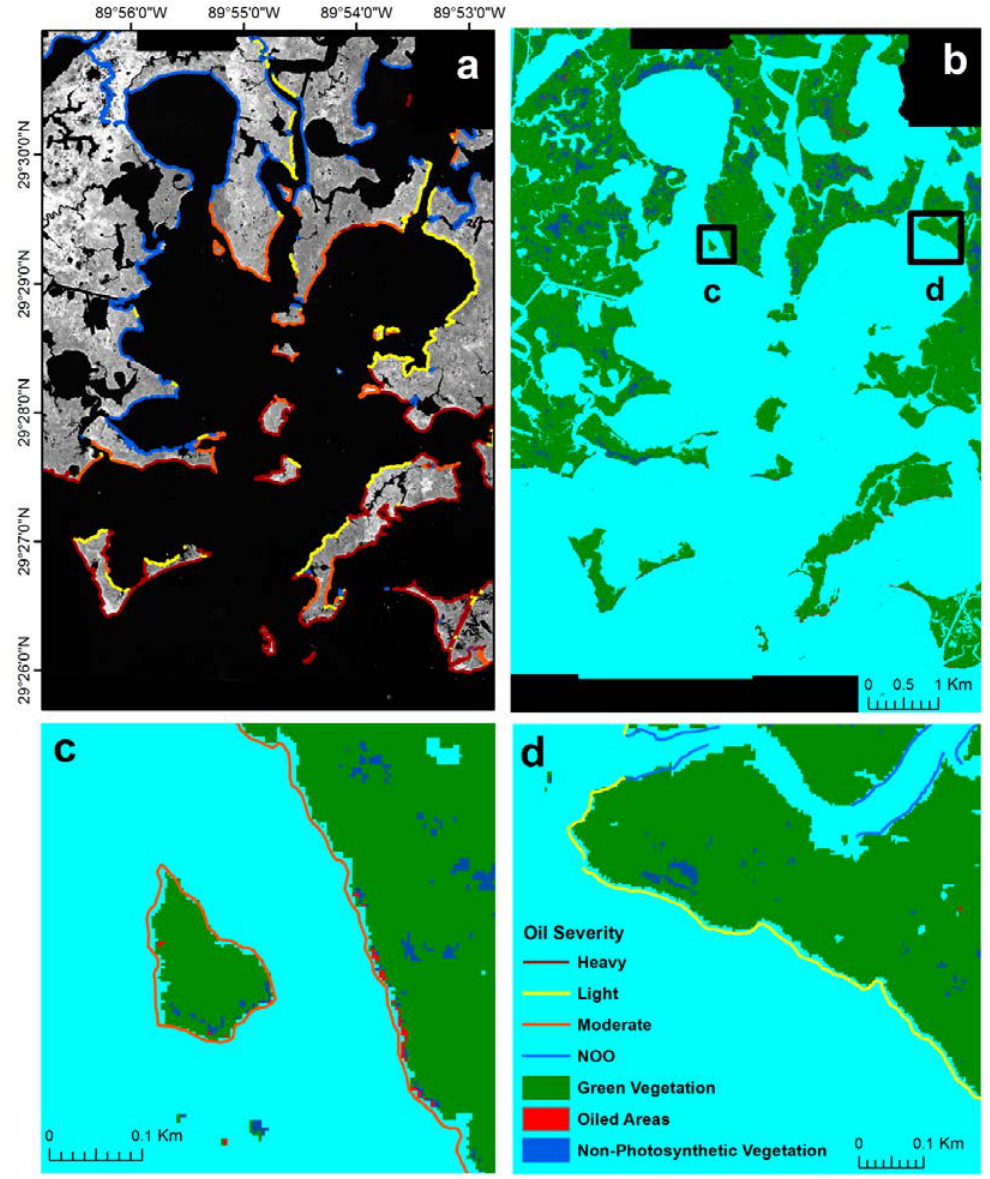
Figure 2. ( a ) SCAT oiled shoreline data overlaid on the AVIRIS flightlines acquired September 14, 2010 over Barataria Bay, ( b ) landcover classification showing location of inset c and d, ( c ) a shoreline designated as moderately oiled by SCAT, with patches of oiled pixels, and ( d ) a shoreline designated as lightly oiled by SCAT with very few oiled pixels.